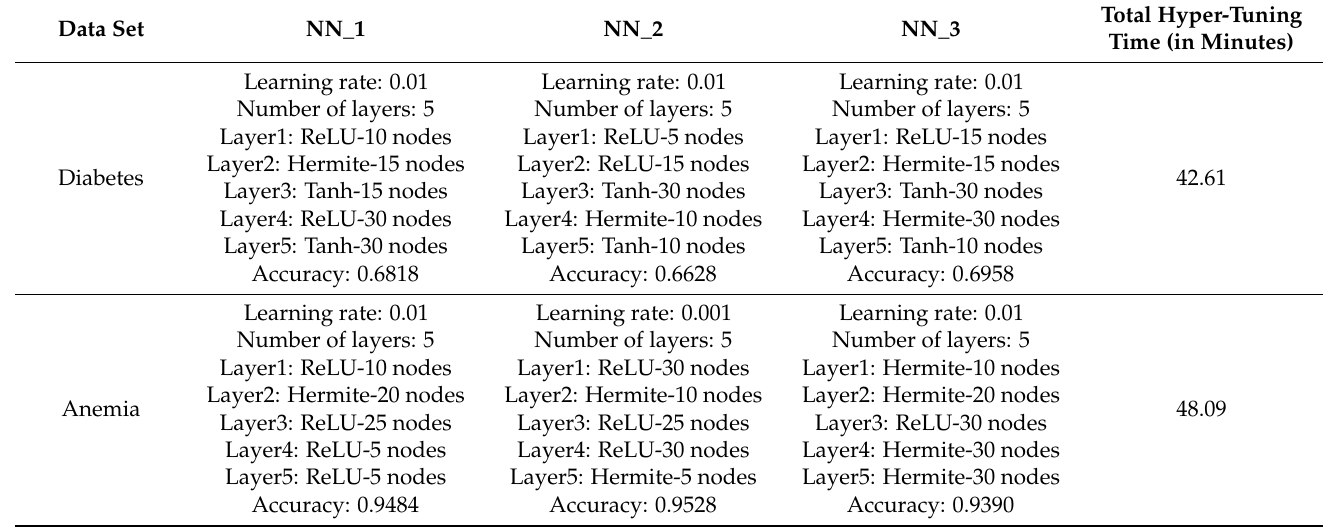
Table 10. (Third experiment-first simulation case) Optimal hyperparameter values, classification (i.e., validation) accuracy evaluated on the validation data, and total time needed to perform the hyperparameter optimization (i.e., total hyper-tuning time) obtained by the three best neural networks NN_1, NN_2, and NN_3 (Data sets: Diabetes and Anemia).